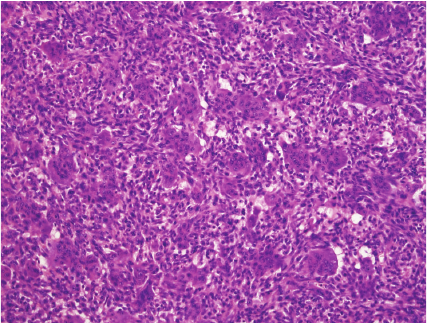
Figure 7: Histology of curettage specimen showed bland spindle cells and intermixed giant cells (hematoxylin and eosin stain,